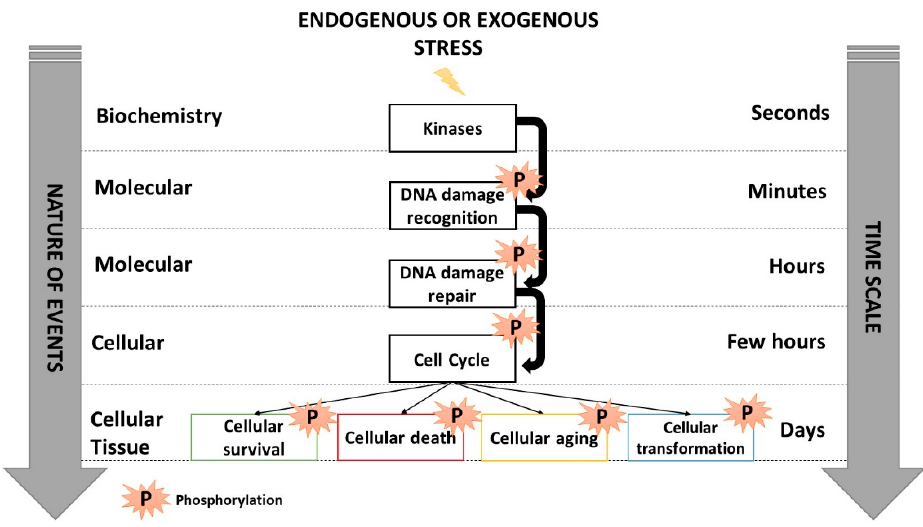
Figure 1. Schematic view of the cascades of phosphorylations occurring in response to IR activated by kinases that trigger DNA damage recognition, repair, cell cycle arrests and cellular death. Inspired from [15].